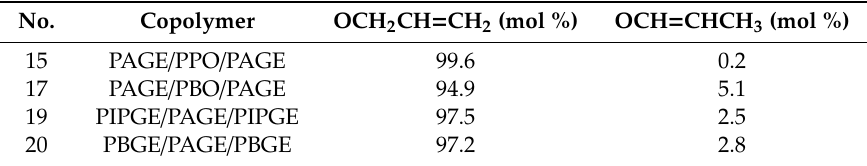
Figure 11. Signals of allyloxy ( a ), ( b ) and cis -propenyloxy ( c ), ( d ) groups observed in the unsaturated region of the 13 C NMR spectrum of PAGE/PBO/PAGE copolyether-diol (17). Table 3. Content of cis -propenyloxy groups derived from isomerization of allyloxy groups in copolyether-diols.